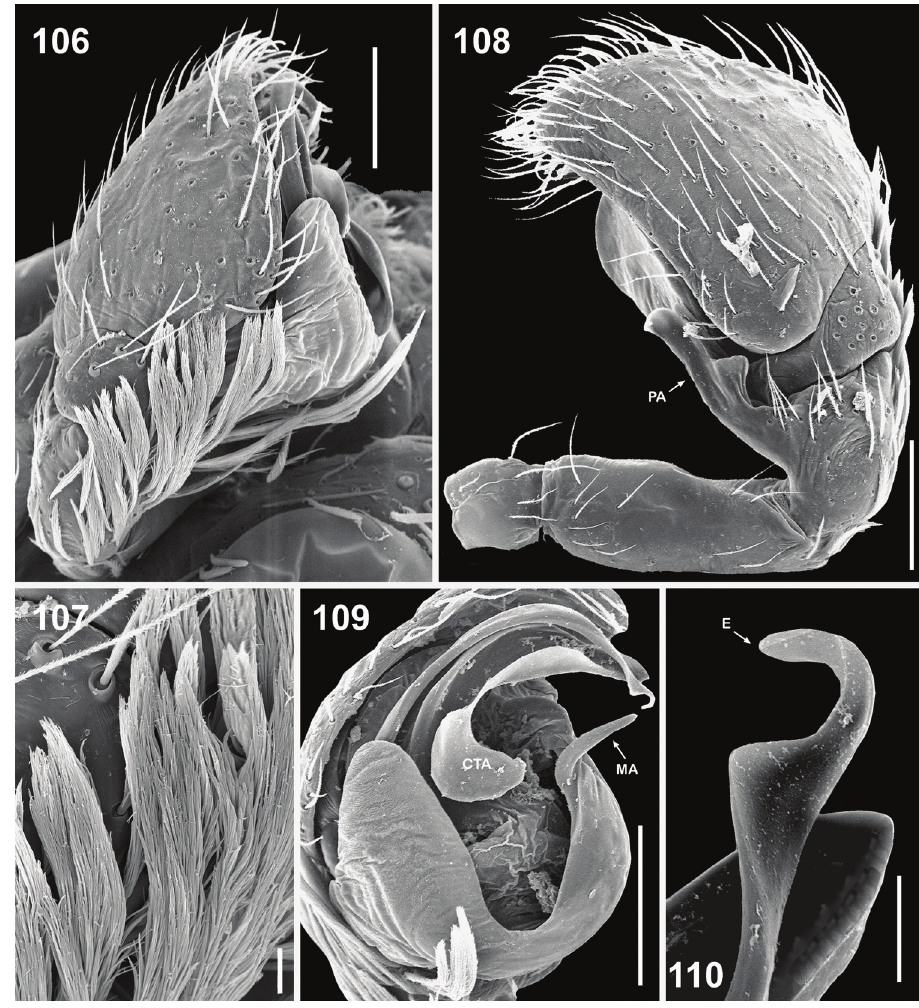
Figures 106–110. Copulatory organs of Eupoa thailandica sp. n. ( ♂ paratype). 106 male palp, median view 107 bunches of white hairs at the base of cymbium, median view 108 male palp, retrolateral view 109 ditto, ventral view 110 embolic tip, apical view. Abbreviations as explained in ‘Material and methods’. Scale bars: 10 μm ( 107, 110 ), 0.1 mm ( 106, 108–109